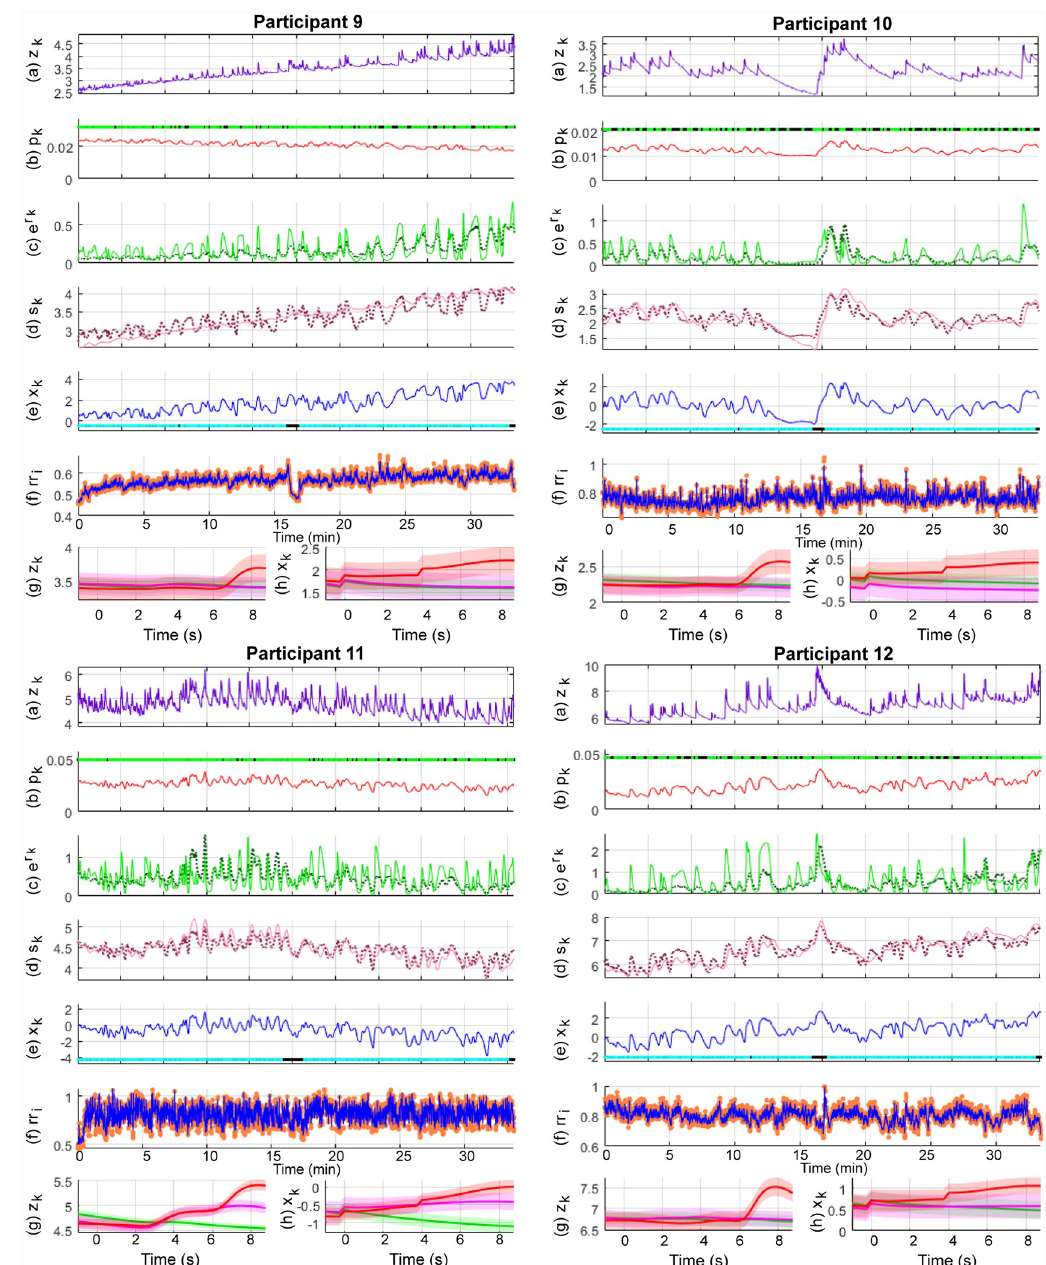
Fig 10. Sympathetic arousal estimation for participants 9-12 in the trace fear conditioning experiment. The sub-panels from top to bottom respectively depict, (a) the skin conductance signal z k ; (b) the presence or absence of SCR peaks (light green and (red line); (c) the exponent of the phasic derived signal r black dots) and the smoothed Bernoulli trial probability estimates of p k k (solid green line) and its estimate (dotted line); (d) the tonic part s k (solid light mauve line) and its estimate (dotted line); (e) the smoothed arousal state estimates of x and the presence or absence of visual or electric stimuli (cyan and blacks dots); (f) the k sequence of RR-intervals rr i (orange dots) and the estimated RR-interval mean μ (solid blue line); (g) a 10 s ERP-like skin conductance plot for the CS- (green), CS+ without a shock (mauve—CS+US-) and CS+ with the shock (red—CS+US+) trials; (h) 10 s ERP-like arousal state plots along with their confidence